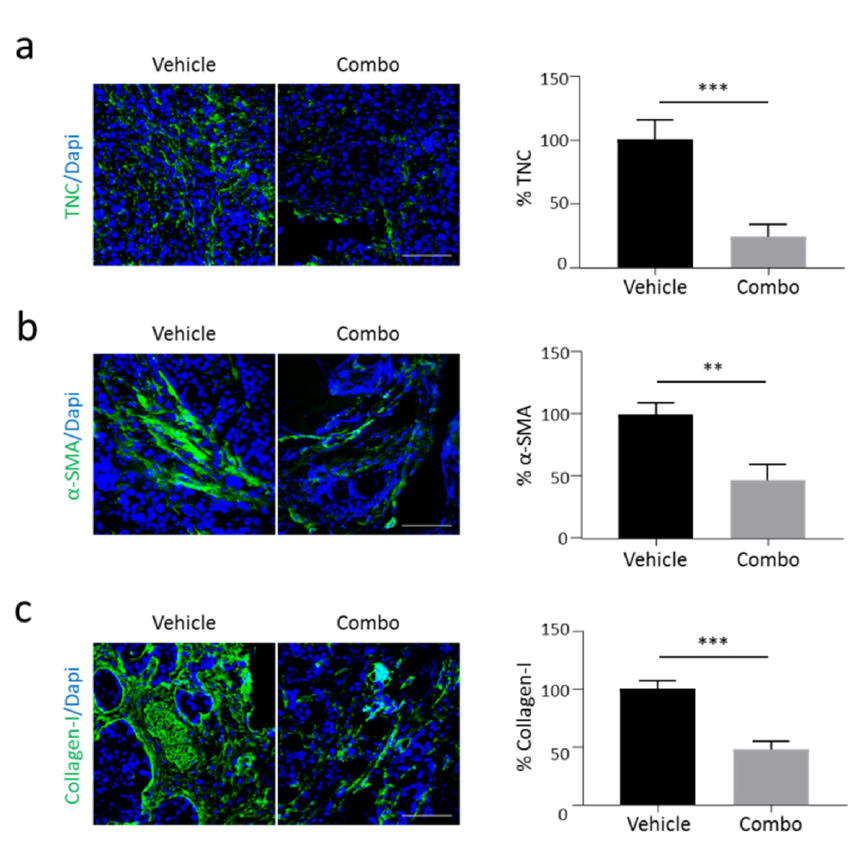
Figure 5. Activation of the HGF/MET axis modulates TNC expression and stroma activation in vivo. Primary tumors excised from hHGF-Ki mice injected orthotopically with Capan-1 human PDAC cells and treated with Vehicle or the MvDN30/DecoyMET K842E combination (Combo) were analysed by immunofluorescence for: ( a ) TNC expression, ( b ) α -SMA expression, and ( c ) Collagen-I expression. Left panels: representative confocal sections showing TNC, α -SMA, and Collagen-I in green, DAPI in blue. Scale bars are 50 µ m. Right panels: bar graphs showing the amount of TNC, α -SMA, or Collagen-I. Data are expressed as percentage of the control. Student’s t test: **, p ≤ 0.01; ***, p ≤ 0.001. Data reported in figure are representative of at least two independent experiments.